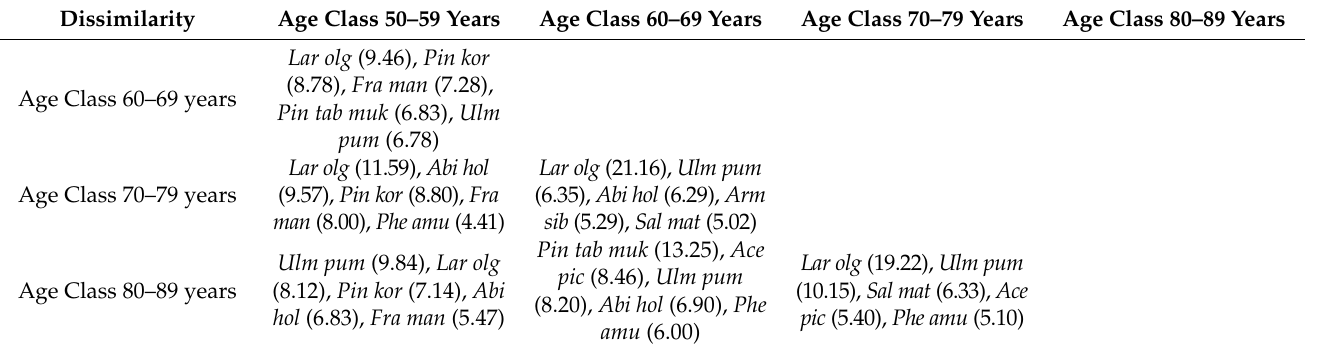
Figure 7. Dissimilarity among age classes based on species richness of middle-aged trees found by SIMPER analysis. Table 5. Main contributing middle-aged tree species to the dissimilarity of different age classes. Values in parentheses represent the contribution of each species to the dissimilarity. For abbreviations of species names, refer to Table A1.